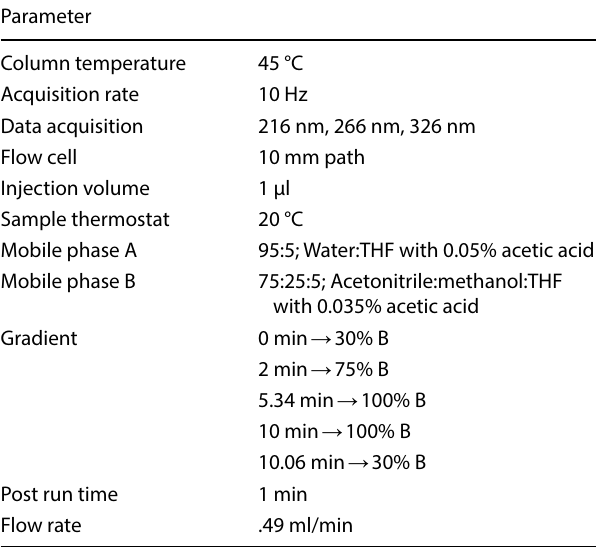
Table 2 Chromatographic parameters used for the Agilent 1290 Infinity LC system